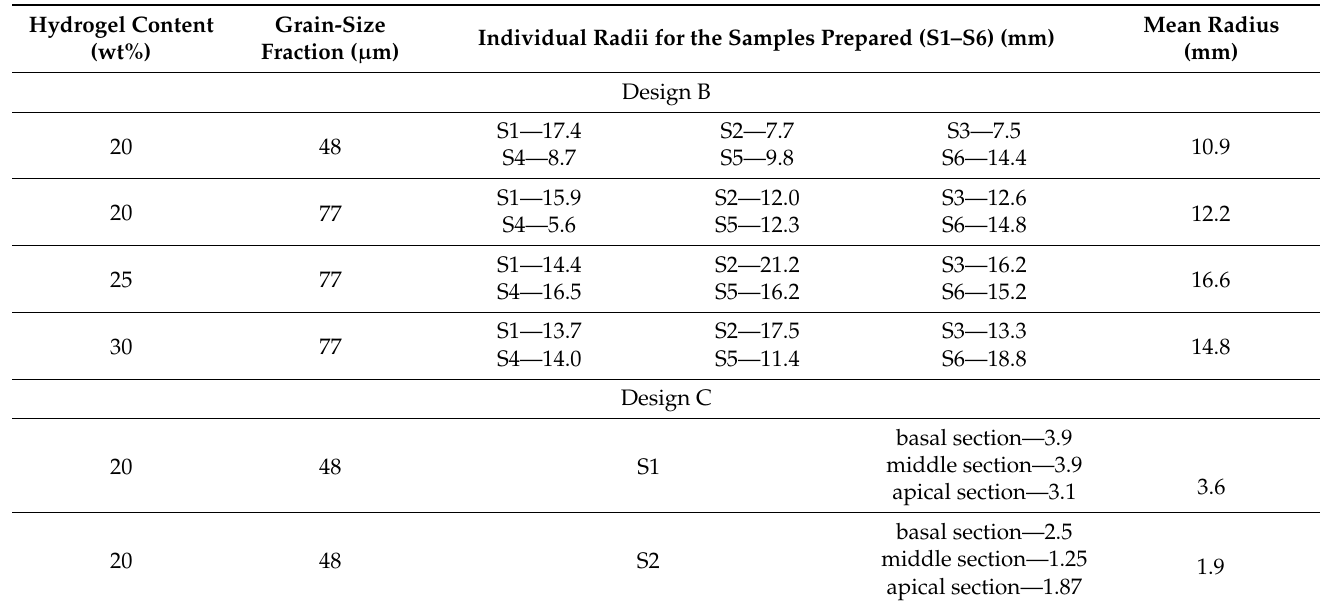
Table 4. Curvature radii determined for samples of designs B and